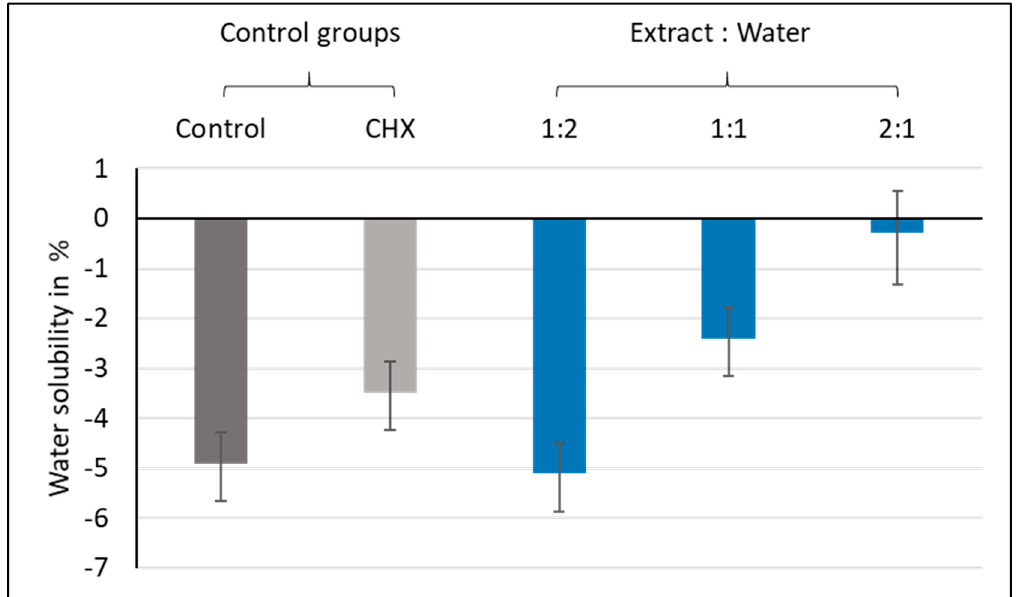
Figure 7. Mean water solubility values (%) showing intergroup comparisons of the control, CHX, and three plant-modified groups (1:2, 1:1, 2:1). Table 2. Results for the ANOVA and Tukey post hoc test for water solubility values for the control,